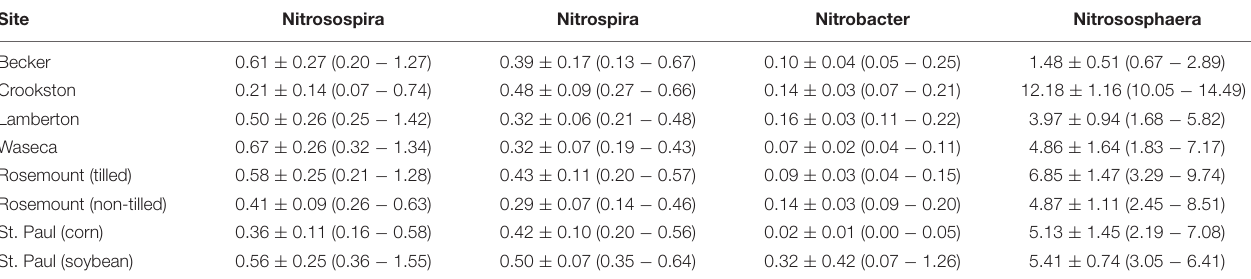
Range is shown in parentheses. All samples from each site are summarized, regardless of time point or